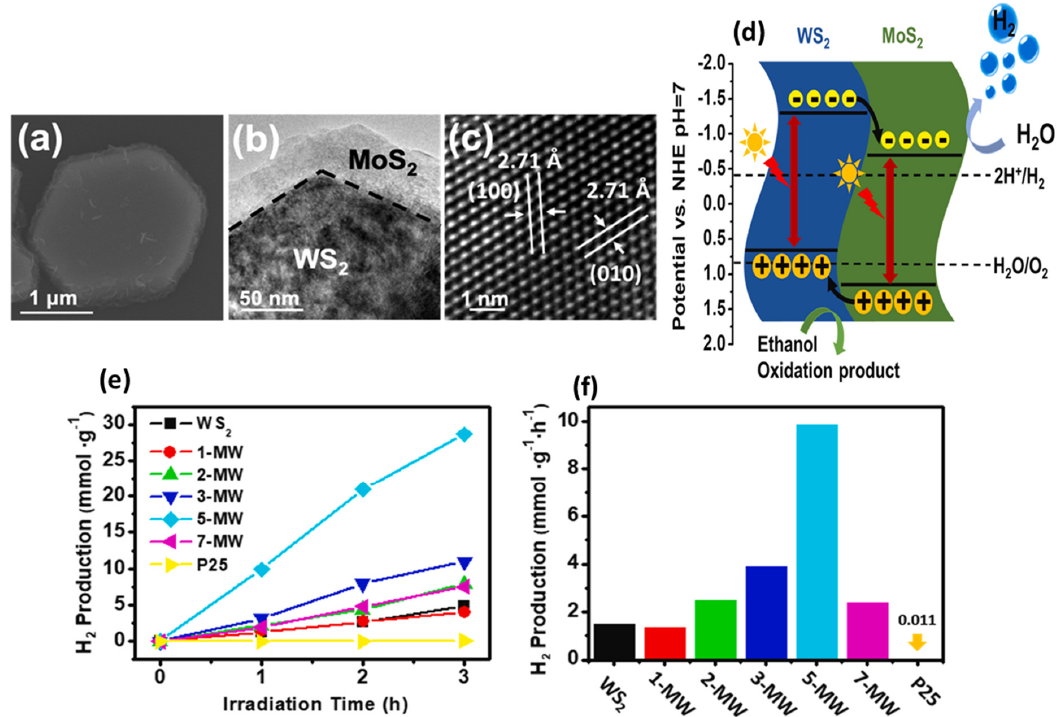
Figure 19. ( a – c ) SEM, TEM, and HRTEM images of the WS 2 /MoS 2 heterostructure, respectively. ( d ) Schematic diagram for the proposed photocatalytic mechanism of hydrogen evolution using the WS 2 /MoS 2 heterostructure as a catalyst. ( e ) Photocatalytic hydrogen evolution and ( f ) hydrogen production rates of WS 2 nanosheets, WS 2 /MoS 2 heterostructures with different MoS 2 wt% and P25 T. Reproduced with permission. [154] Copyright 2021, Elsevier.